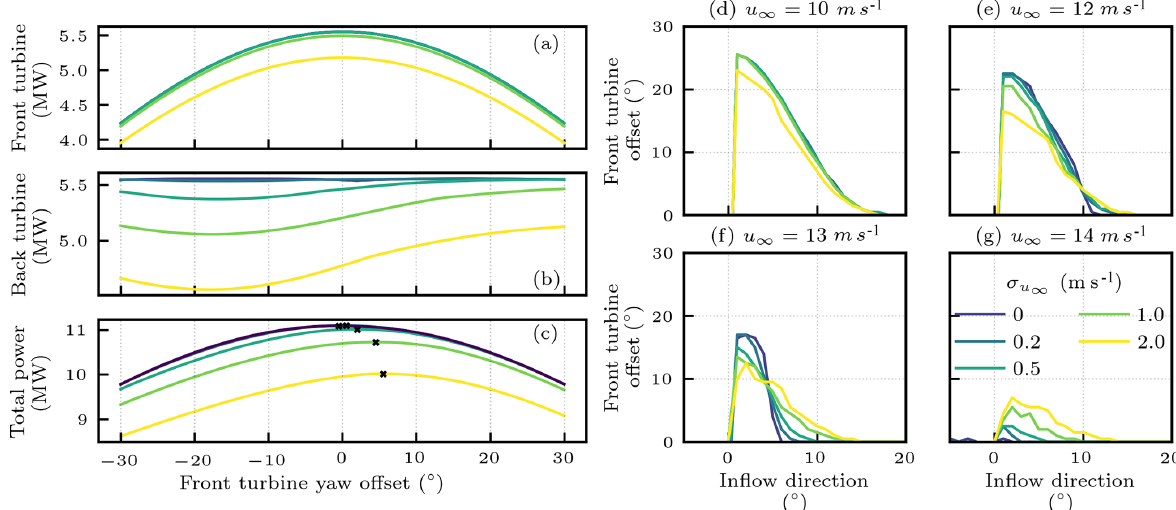
Figure 8. Power production for the front (a) , back (b) , and both (c) turbines as a function of front turbine yaw offset in the two-turbine case with 13ms − 1 inflow 7 ◦ from north. Different line colors indicate different values of σ u , as indicated by the legend in panel (g) , with ∞ brighter colors corresponding to larger σ u and, hence, greater uncertainty in inflow speed, u ∞ . The black crosses in panel (c) denote optimal ∞ front turbine yaw settings. Panels (d) – (g) show the optimal front turbine yaw offset as a function of inflow direction for inflow speeds, u ∞ , of 10, 12, 13, and 14ms − 1 , respectively. Only positive inflow directions are shown to highlight the important effects of uncertainty.